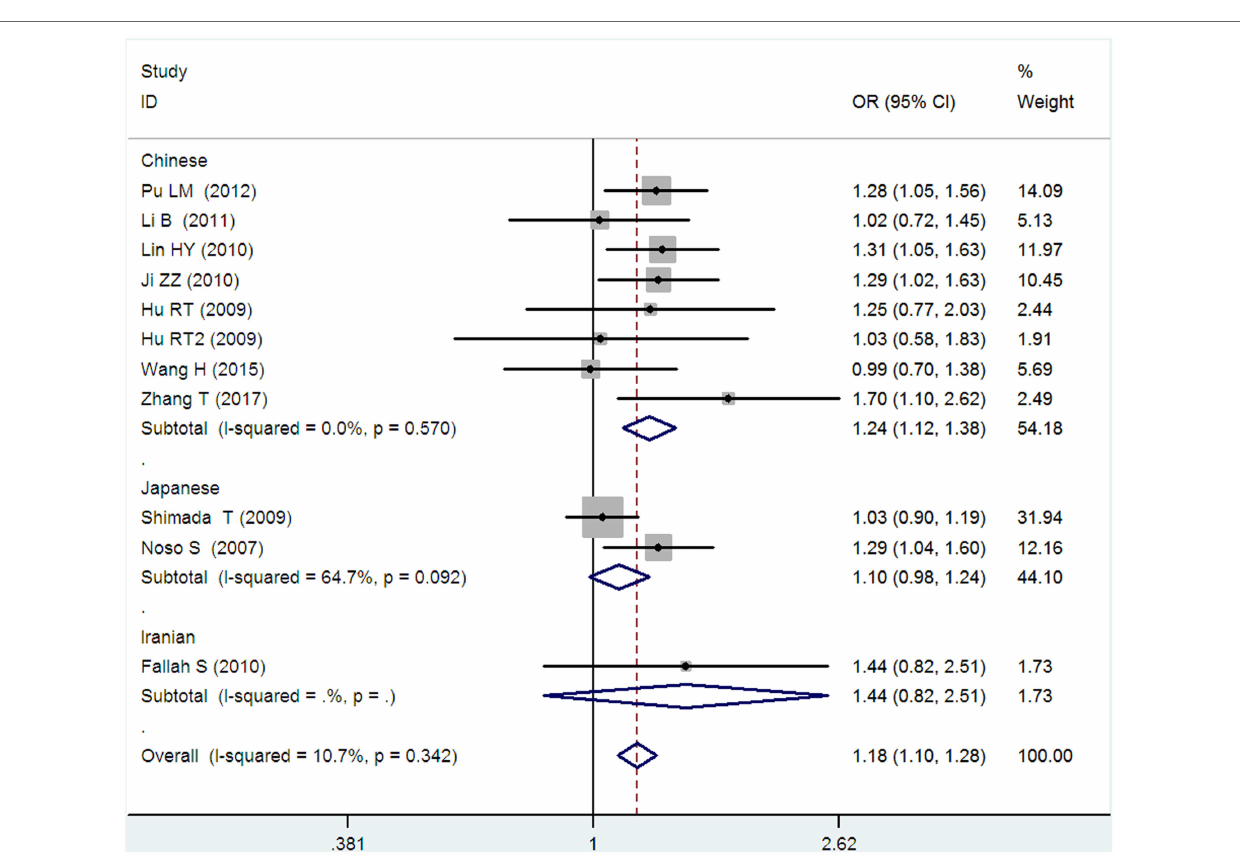
FigUre 6 | Forest plot of type 2 diabetes mellitus associated with small ubiquitin-like modifier 4 gene M55V polymorphism under an additive genetic model (V vs.